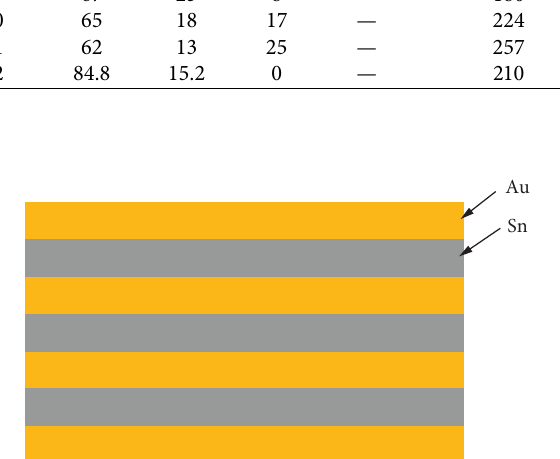
Figure 15: Gold-tin laminated soldering